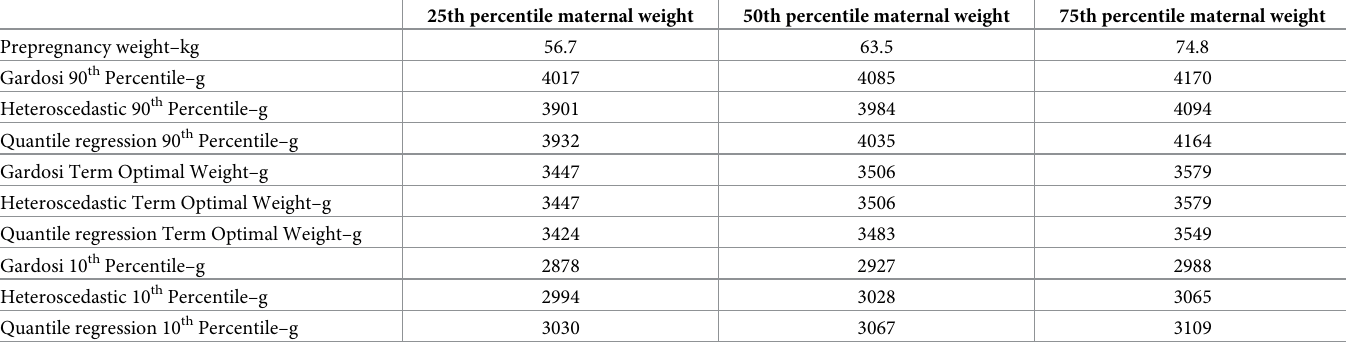
Table 3. Comparison of three different methods across different levels of maternal prepregnancy weight for birthweight at 37–42 weeks in the NICHD Fetal Growth Studies–Singletons (N =